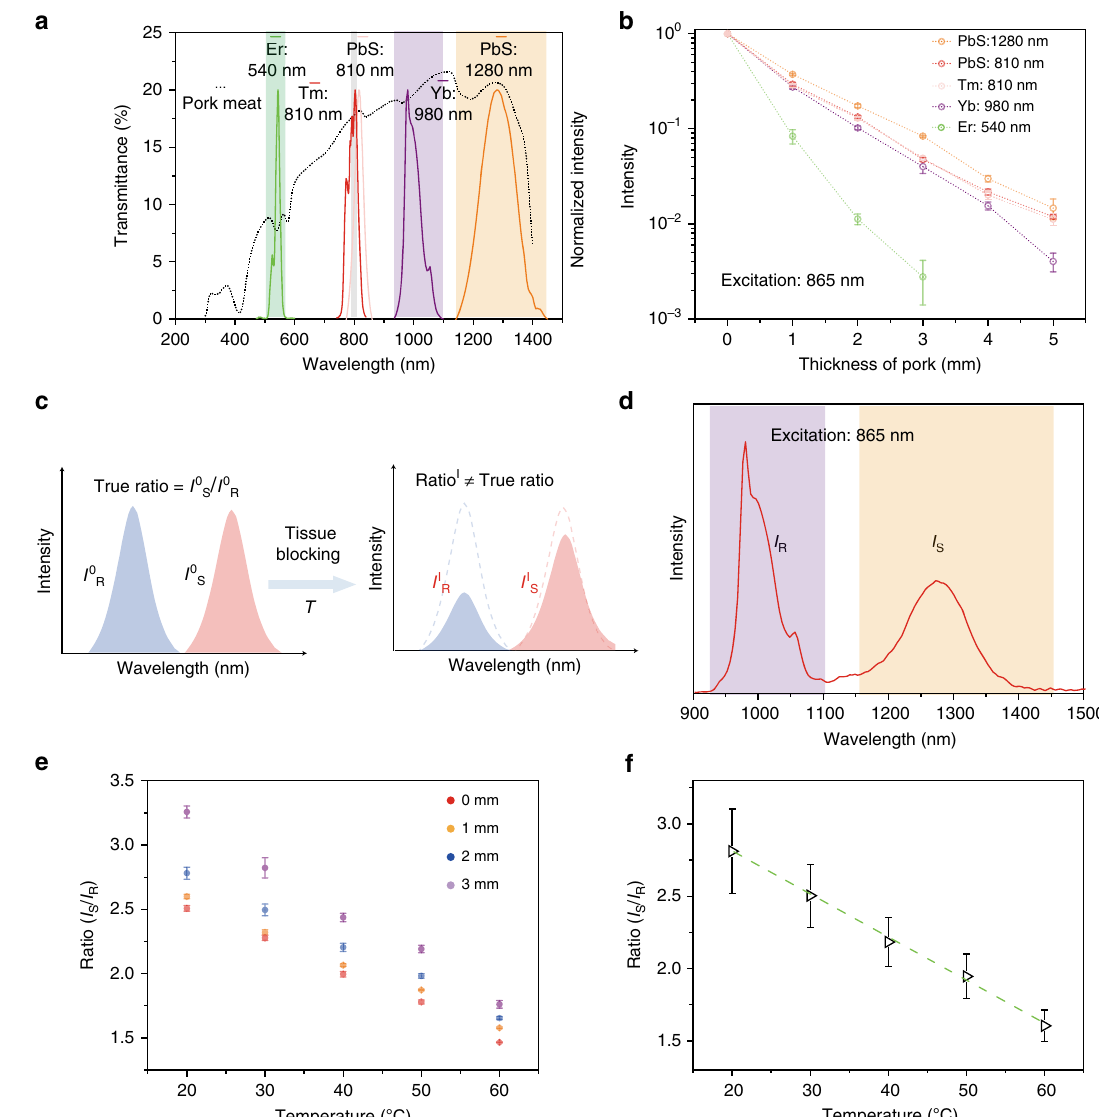
Fig. 3 Errors caused by wavelength difference. a Transmittance spectrum (left axis) of 1 mm pork and emission spectra (right axis) of Er-UCNPs, Tm- nanoparticles and PbS QDs. b Normalized intensities obtained from Er-UCNPs, Tm-nanoparticles and PbS QDs with respect to thickness of the pork tissue slice under excitation of 865 nm laser. Each data set and error bars de fi ned as s.d. were based on three measurements by spectrometry. c Schematic illustration of conventional luminescent ratiometric thermometry with different wavelength emissions. d Stokes emission spectrum of UCL-NCs under excitation of 865 nm laser. I R and I S are the reference emission (Yb 3 + emission, 980 nm) and temperature sensitive emission (PbS emission, 1280 nm), respectively. e Ratios of I S to I R at different temperatures with blocking of various pork tissue slice. Data and error bars, de fi ned as s.d., were based on three measurements by spectrometry. f A plot of I S / I R versus T to calibrate temperature. Average values of I S / I R under different temperatures were obtained from the ratios with blocking due to pork tissue slice of different thickness (0, 1, 2, and 3 mm). Error bars were de fi ned as s.d. Source data are provided as a Source Data fi